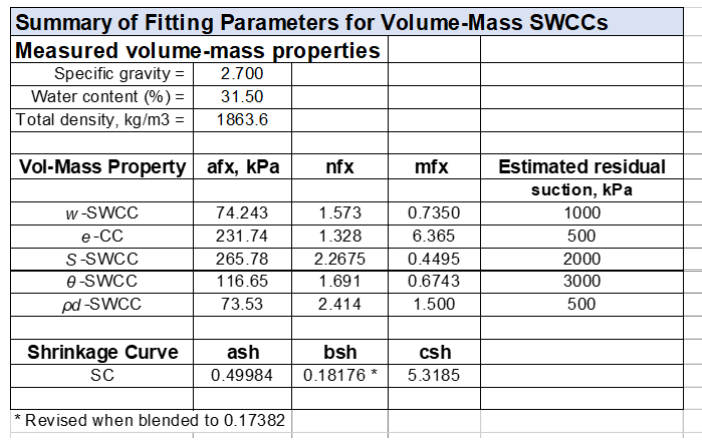
Figure 19. Summary of the fitting parameters for the volume-mass unsaturated soil functions.